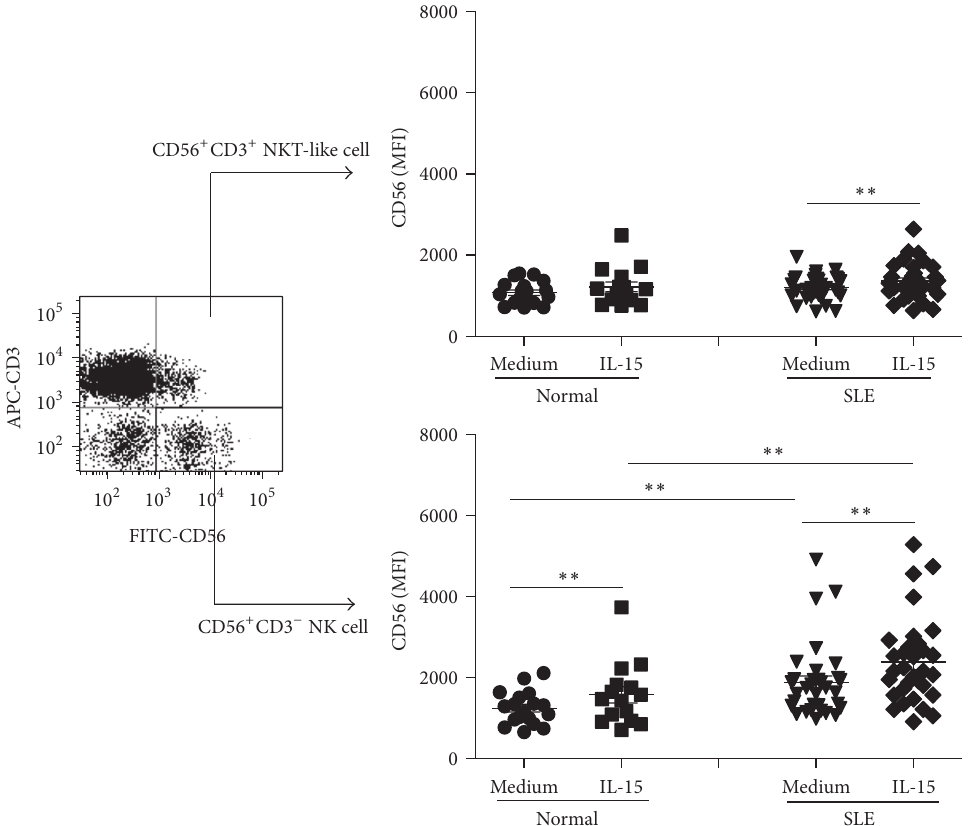
Figure 2: Effect of interleukin- (IL-) 15 on CD56 expression of CD56 + CD3 − NK cells and CD56 + CD3 + NKT-like cells from SLE patients and healthy controls. PBMCs were stimulated with IL-15 (10ng/mL) for 18 hrs and stained with anti-CD3 and anti-CD56. The CD56 + CD3 − NK and CD56 + CD3 + NKT-like cell population were separated by flow cytometry as illustrated. Data was expressed as mean fluorescence intensity (MFI) ± SEM. ∗∗ 𝑝 < 0.01 (normal, 𝑛 = 17 ; SLE, 𝑛 = 33 ).